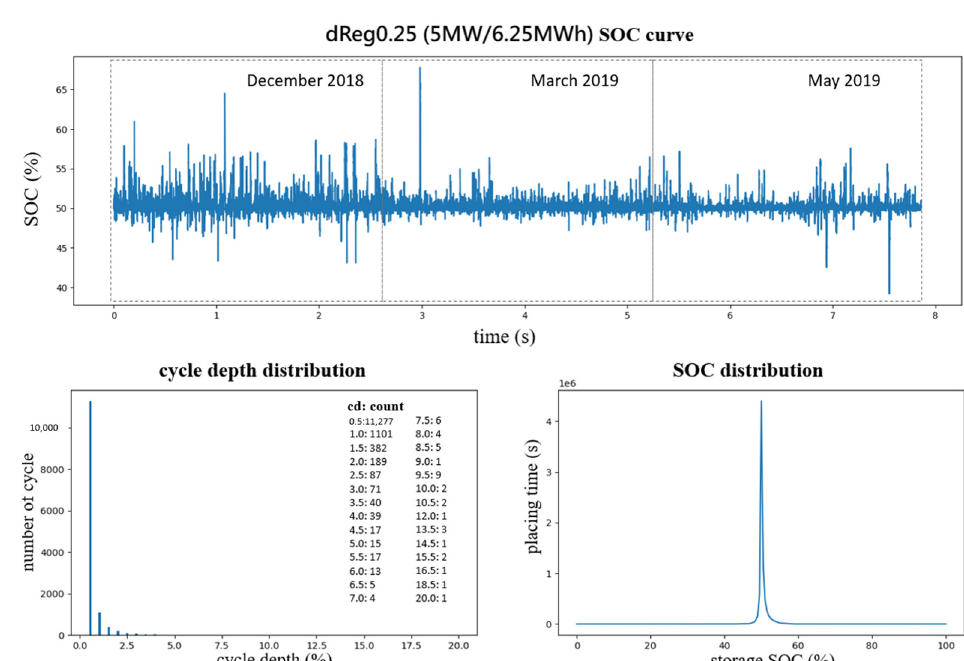
Figure A7. SOC curve and aging features of Scenario 5.